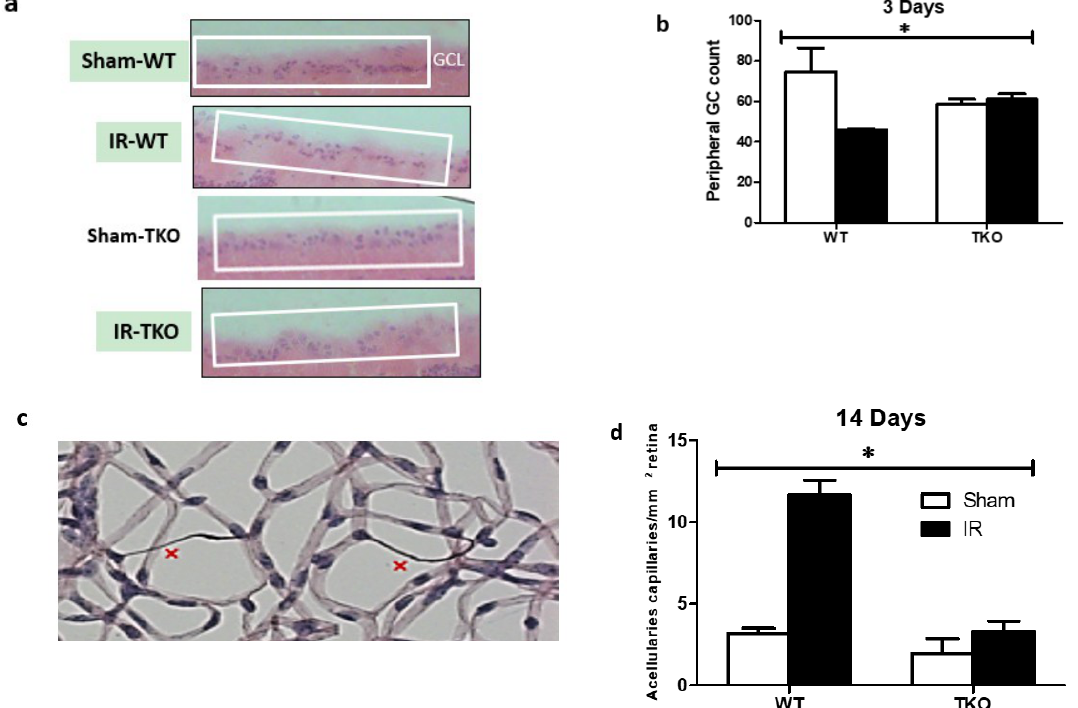
Figure 6. ( a , b ) Representative images and statistical analysis showing IR caused significant reduction in total number of cells in ganglion cell layer (GCL) in the peripheral retinas of the WT, but not of TKO mice when compared to shams after 3-days. ( c , d ) Representative image and statistical analysis showing IR significantly increased development of occluded (acellular) capillaries in WT, but not TKO mice when compared to shams after 14-days. ( n = 8–10, * p < two way ANOVA showed disease and gene interaction, * P <